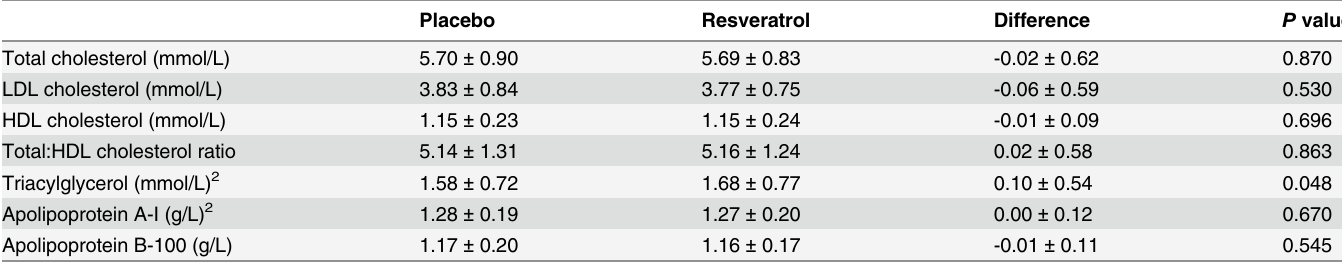
Table 2. Effect of 4-wk resveratrol intake on serum lipids and lipoproteins. 1